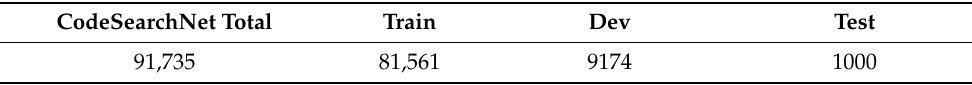
Table 5. Number of data by CodeSearchNet data reconstruction.